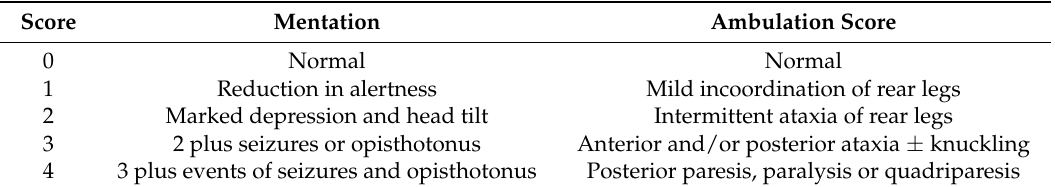
Table 2. Mentation and ambulation scoring